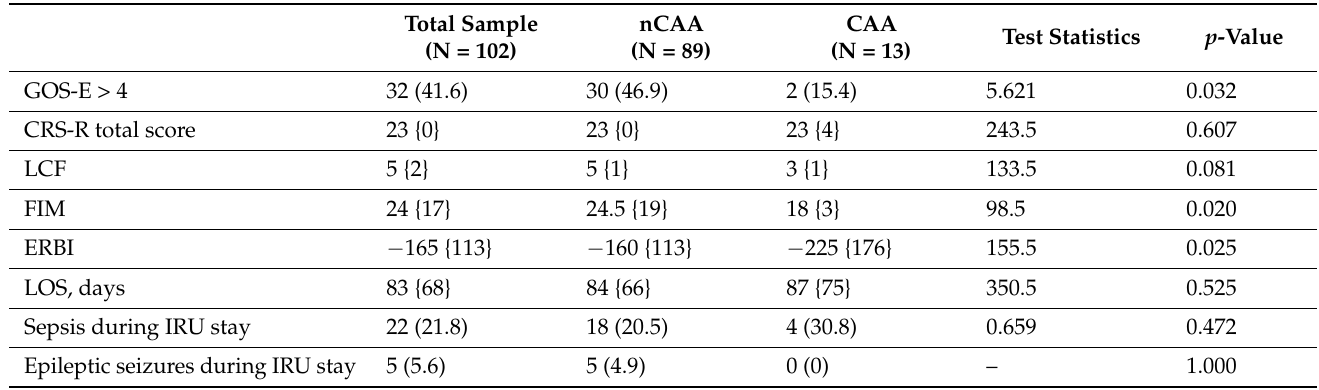
Table 2. Demographic and clinical characteristics of the study sample at discharge.